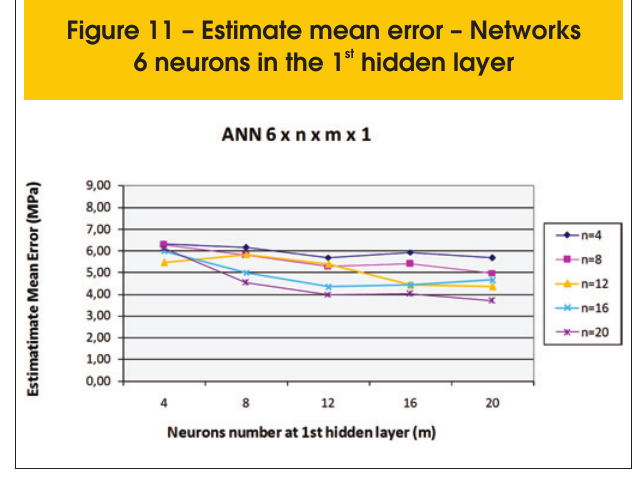
Figure 11 – Estimate mean error – Networks st 6 neurons in the 1 hidden layer